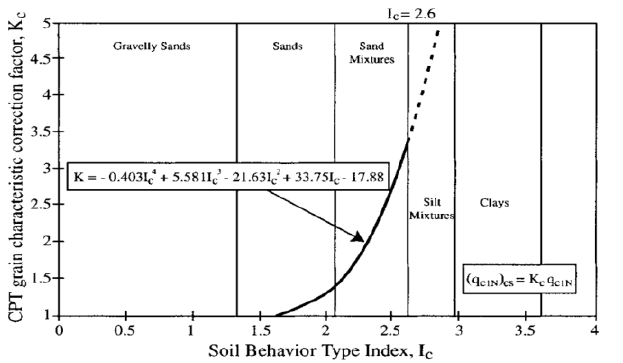
Figure 4: K c curve interpolation to determine corrected CPT tip resistance for equivalent clean sand based on different granular soil characterization Robertson and Wride